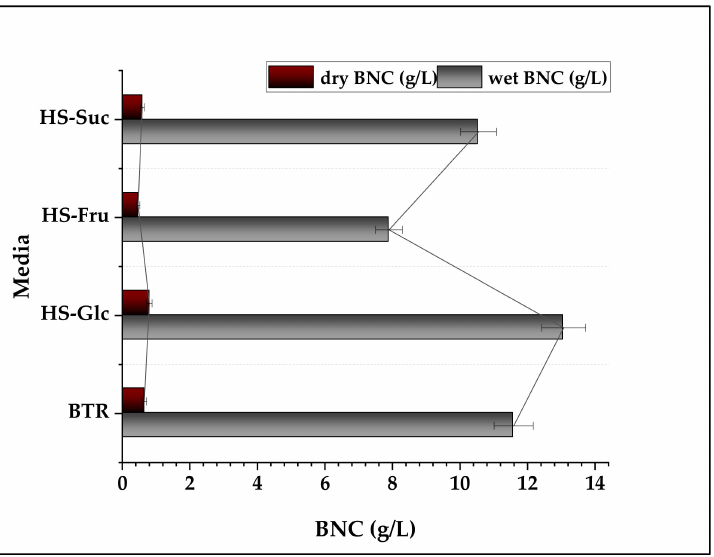
Figure 4. Effect of different carbon sources on BNC moisture